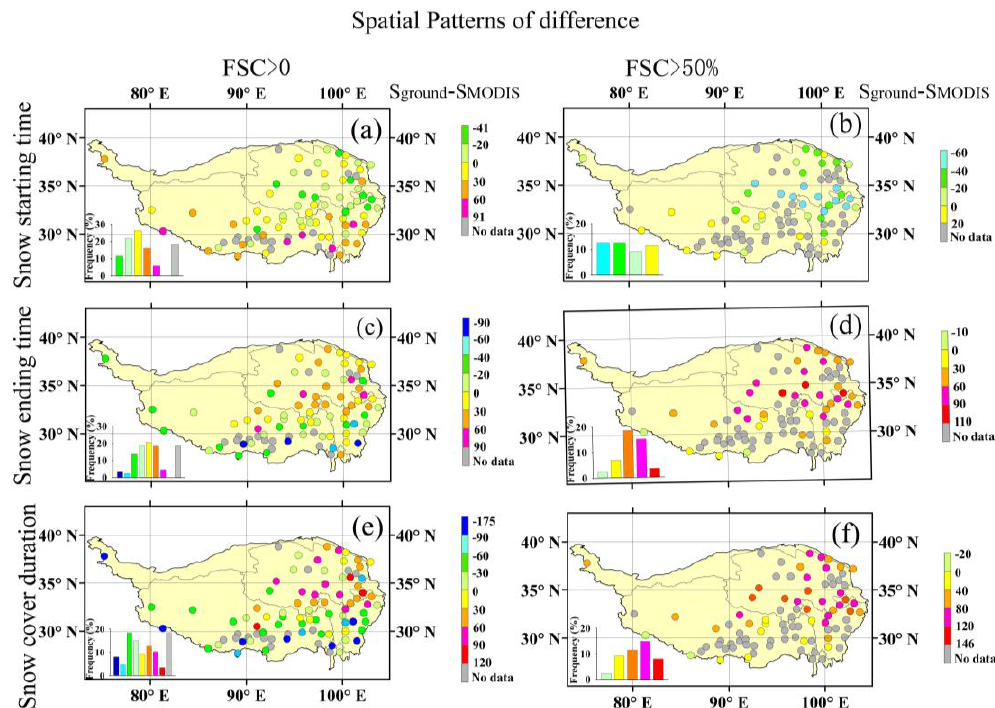
Figure 9. Spatial patterns of difference (S ground -S MODIS ) in snow starting time ( a , b ), snow ending time ( c , d ), and snow cover duration ( e , f ) on the threshold of FSC >0 and FSC >50%. S ground and S MODIS are the annual value of snow-cover phenological variables (i.e., snow starting time, snow ending time, and snow cover duration) for in situ observation and the MODIS data at 71 sites (FSC >0) and 40 sites (FSC >50%) from 2000 to 2010, respectively. The inset graph at the bottom left shows the frequency distributions of the corresponding spatial patterns of difference.